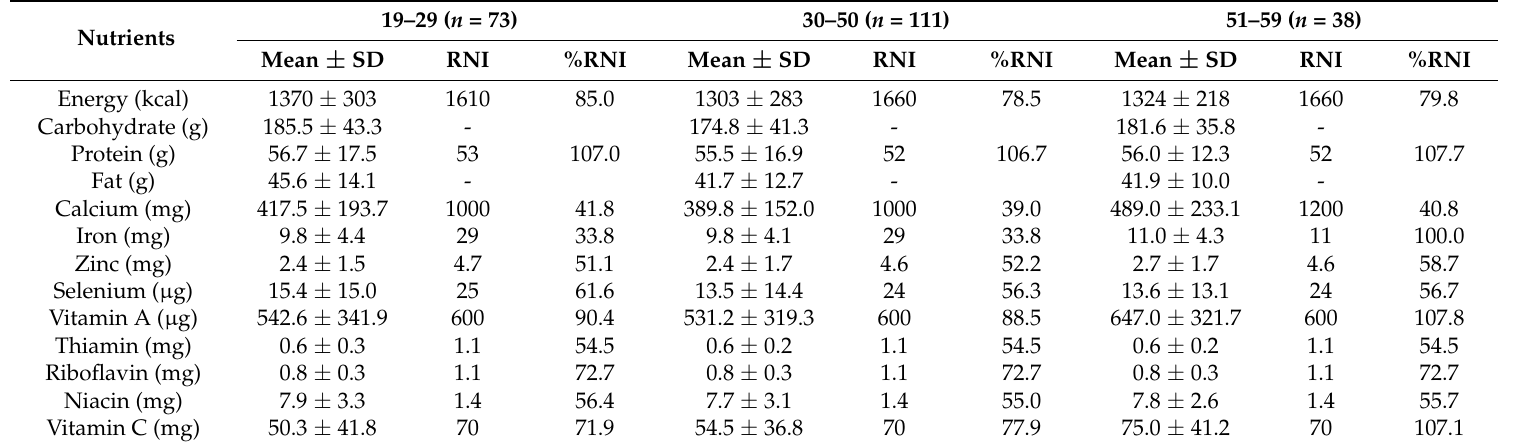
Table 4. Energy and nutrients intake of respondents by age groups ( n = 222).